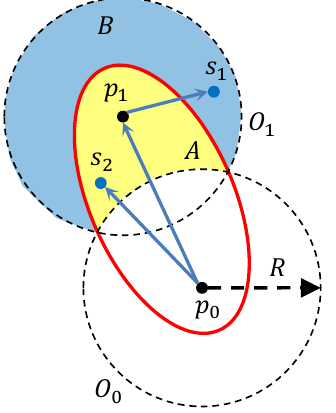
Figure 3. Illustration of the coverage of two charging stations p 0 and p 1